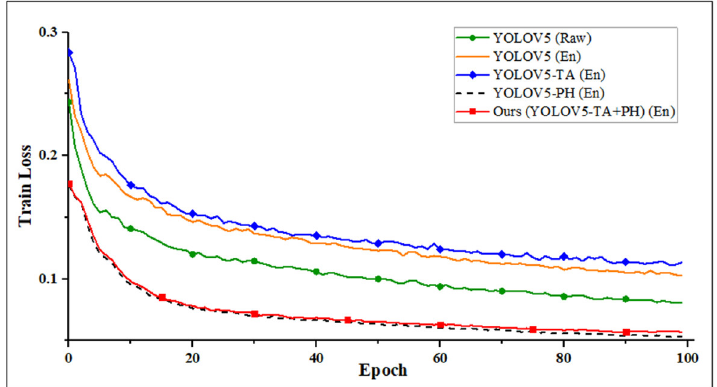
Figure 8. Loss curves of the proposed model and the other comparable models.